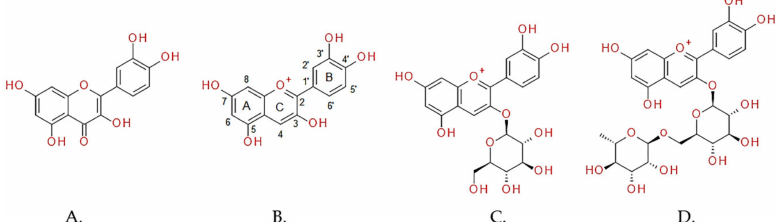
Figure 1. Chemical structures of ( A ) quercetin, ( B ) cyanidin, ( C ) kuromanin (cyanidin 3-glucoside), and ( D ) keracyanin (cyanidin